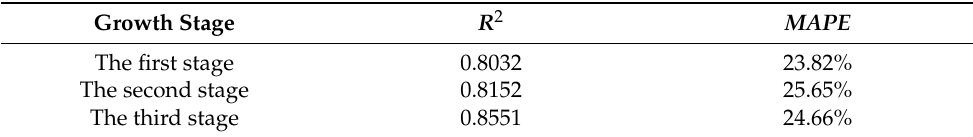
Table 12. R 2 and MAPE for the SVR fresh weight model.